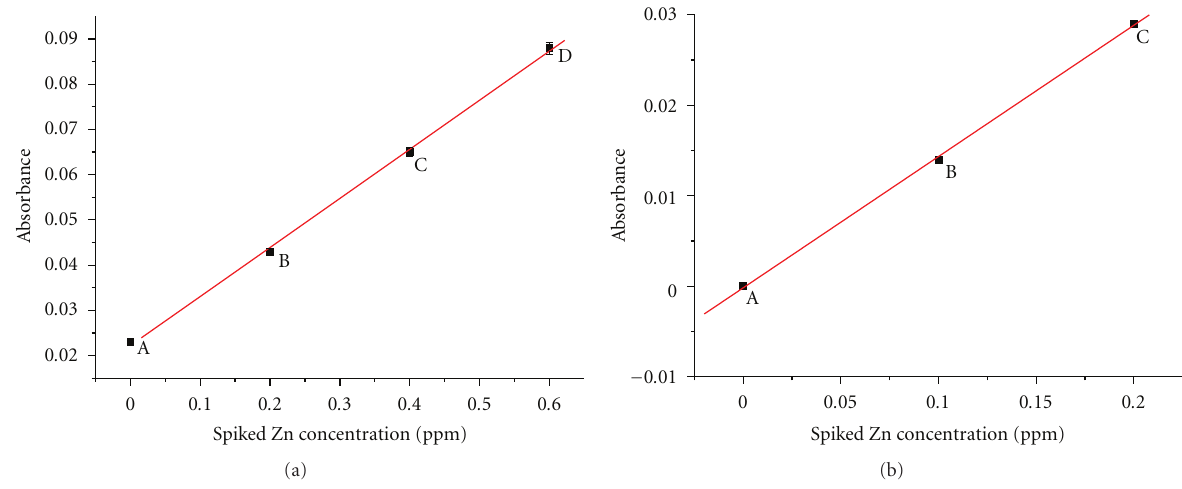
Figure 3: Calibration curves for the additions of zinc in (a) RING-H2 and (b) mutant RING (C955R) of Arkadia.